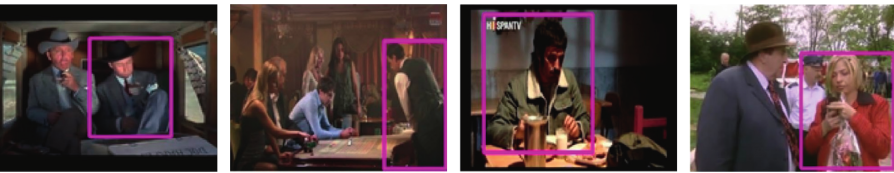
Figure 3: Vlog dataset.